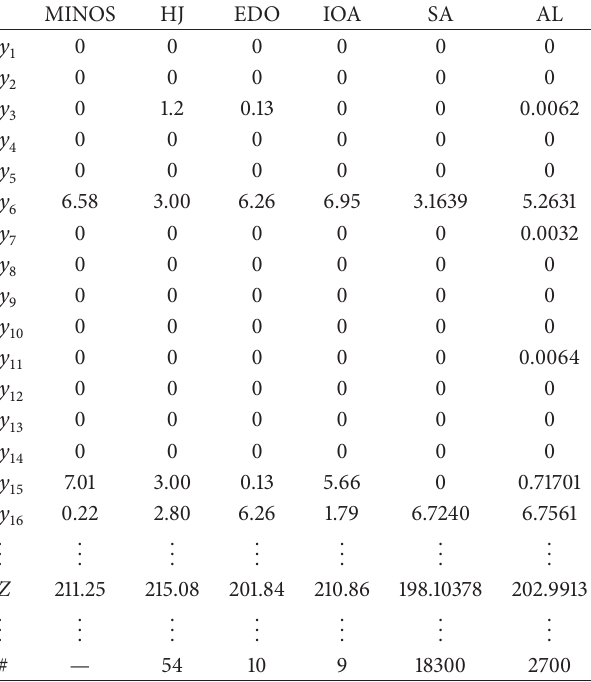
Table 4: Comparison of results from solving the 16-link network for scenario 1